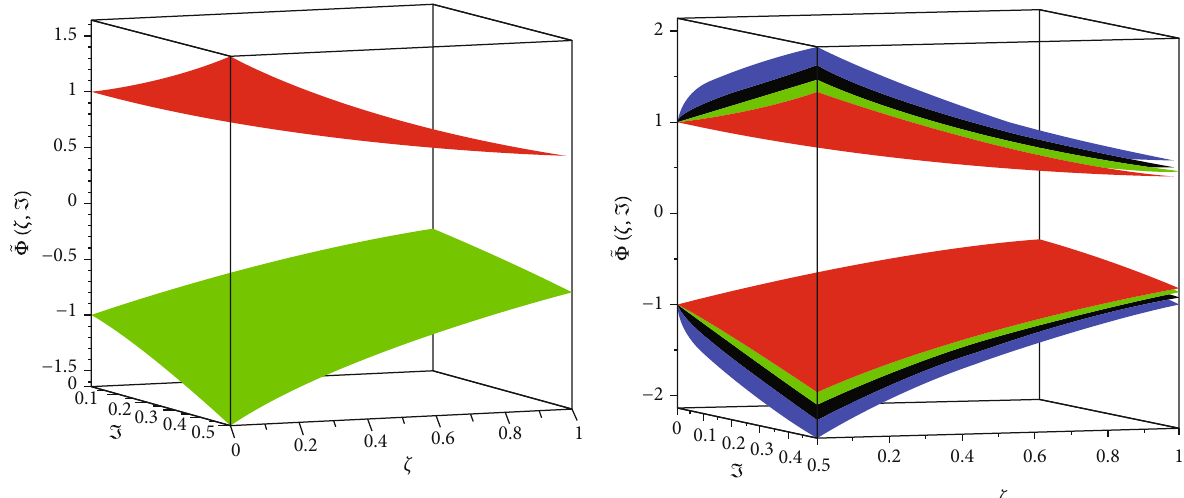
Figure 3: First graph shows the three dimensional fuzzy lower and upper branch graph of analytical series solution and second graph the di ff erent fractional-order of ν .